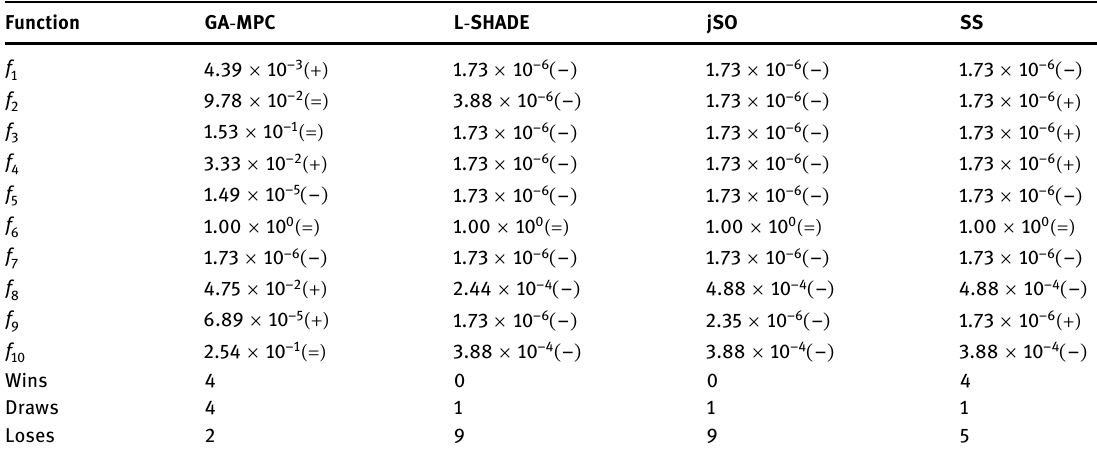
Table A6: The CEC 2020 ( = D 20 ) statistical analysis showing the Wilcoxon test p -